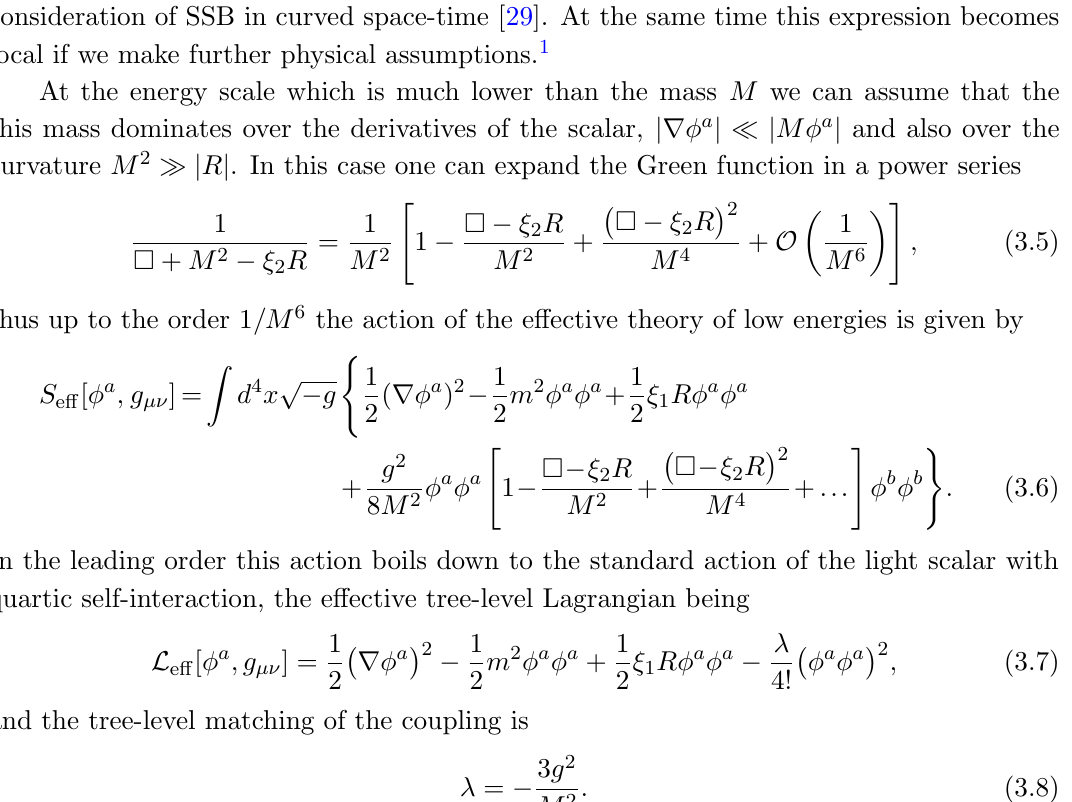
Figure 1 . Matching in terms of Feynman diagrams at the tree level. On the left side is the diagram of the fundamental theory, dots referring to di(cid:11)erent permutations of the momenta. At the right, the diagram corresponds to the e(cid:11)ective